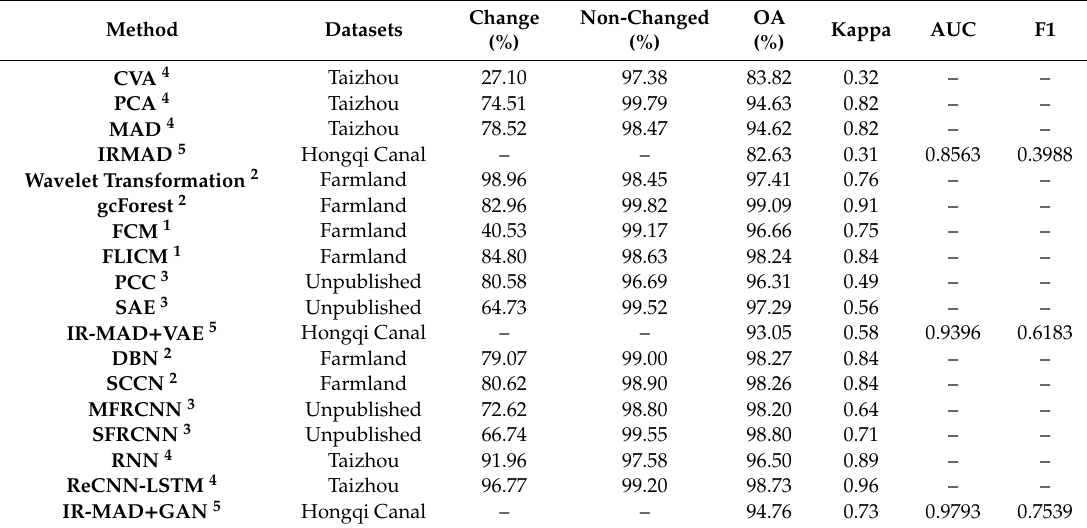
Figure 18. A summary diagram of the methods of change extraction. Table 1. Comparison of representative change extraction methods based on pixel analysis.